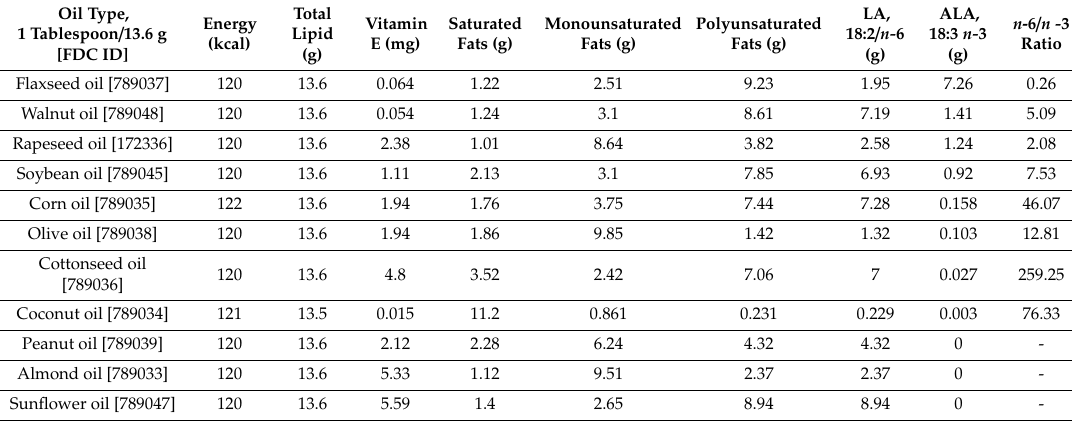
Table 2. ALA content and principal nutrition facts of selected edible